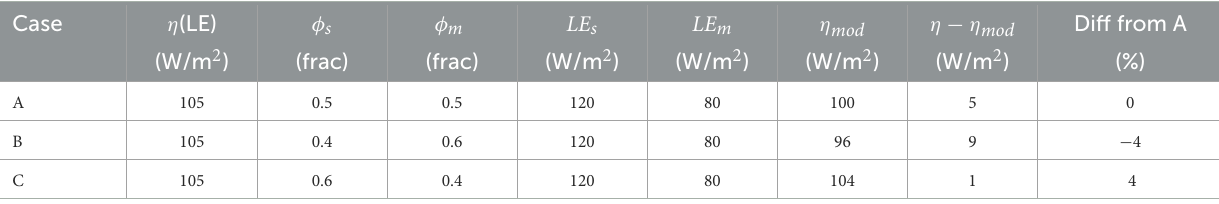
TABLE 1 Comparison between the random and organized heterogeneous mosaic cases (Figure 4) toward the estimation of latent heat flux, η ≡ LE